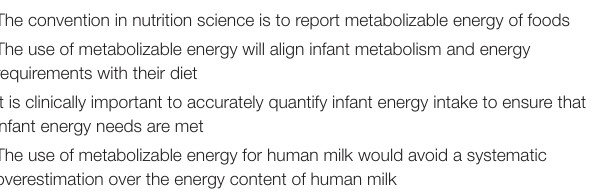
the energy content, it is important to obtain the same